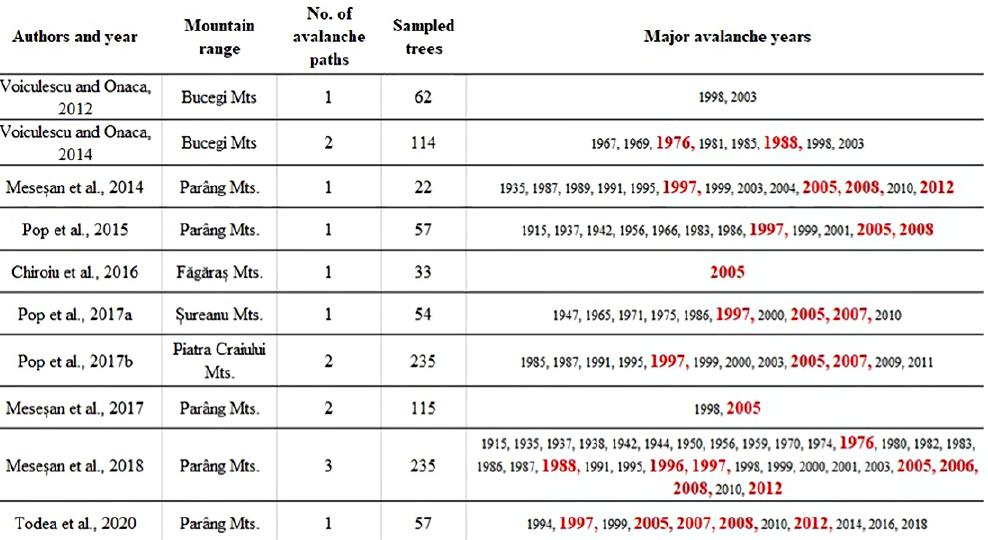
Table 2. Southern Carpathians tree-ring based snow avalanche reconstructions (avalanche years identified in the present study as well are marked with